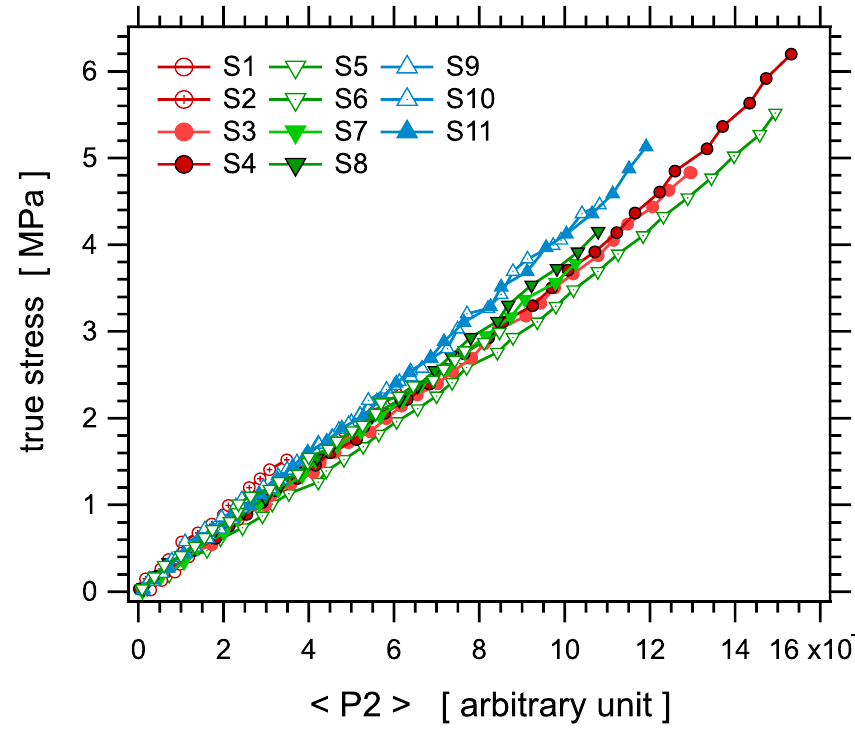
Figure 14. True stress as a function of the orientation parameter P 2